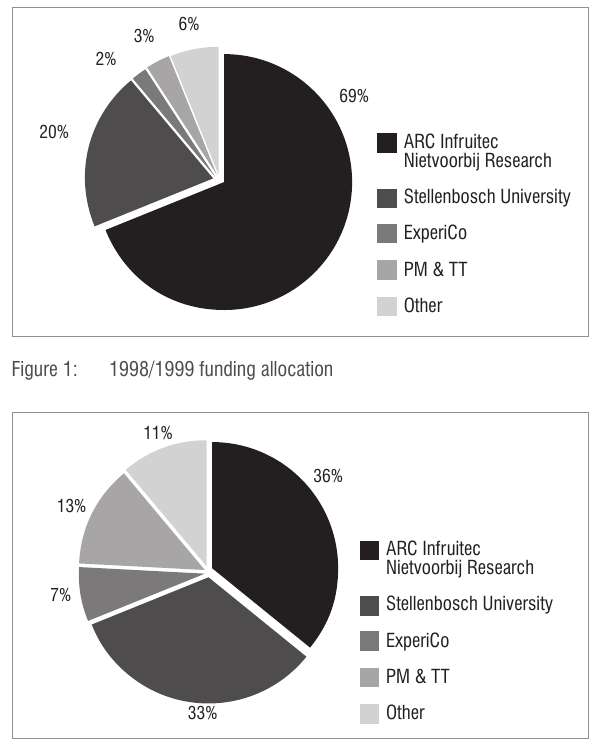
Figure 2: 2010/2011 funding